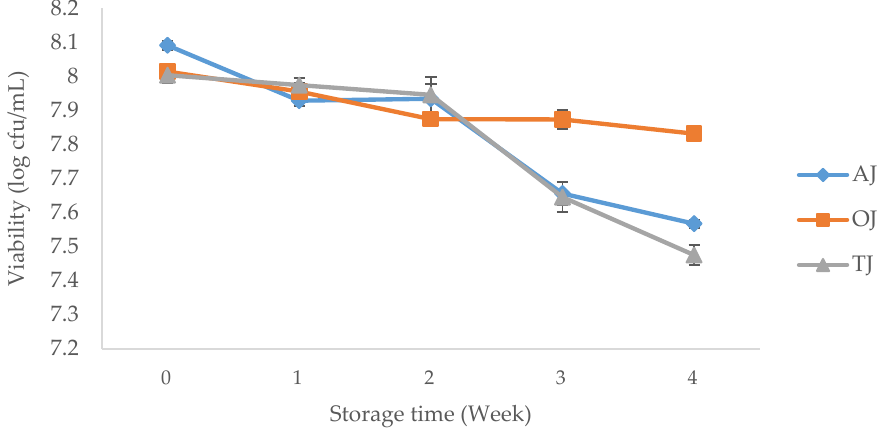
Figure 2. The viability of Lactobacillus sanfranciscensis during 4 weeks of storage under 4 °C. AJ, probiotic-fortified apple juice; OJ, probiotic-fortified orange juice; TJ, probiotic-fortified tomato juice.